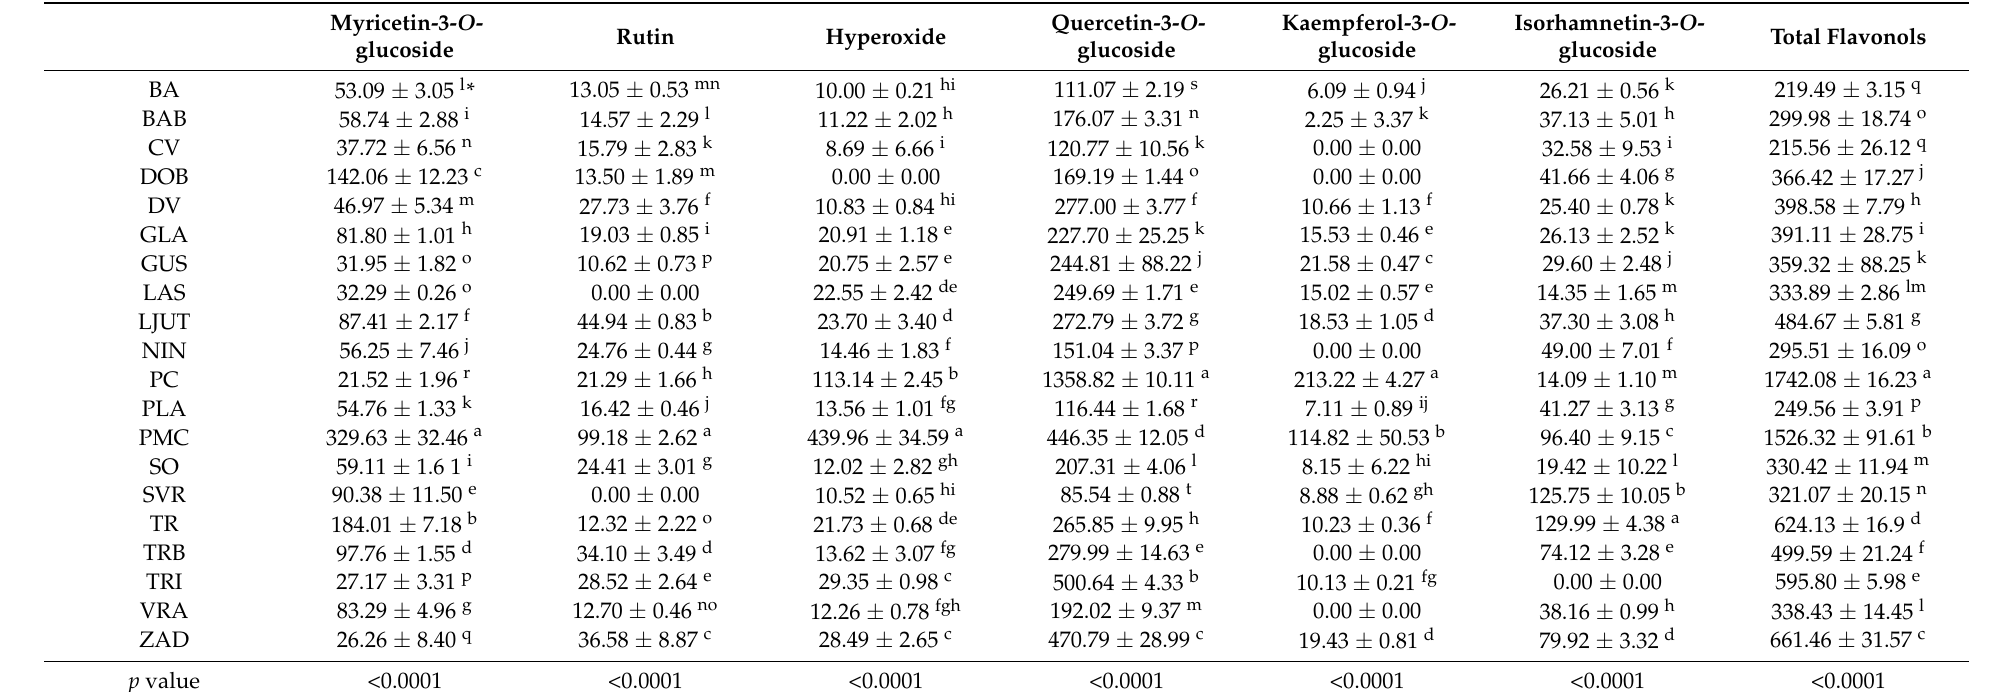
Table 2. Flavonols profile of Croatian autochthonous grape